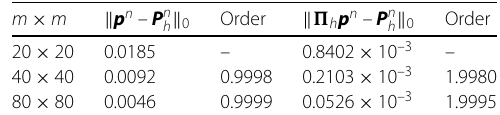
Table 8 Numerical results at t = 1.0 with τ = 5 h